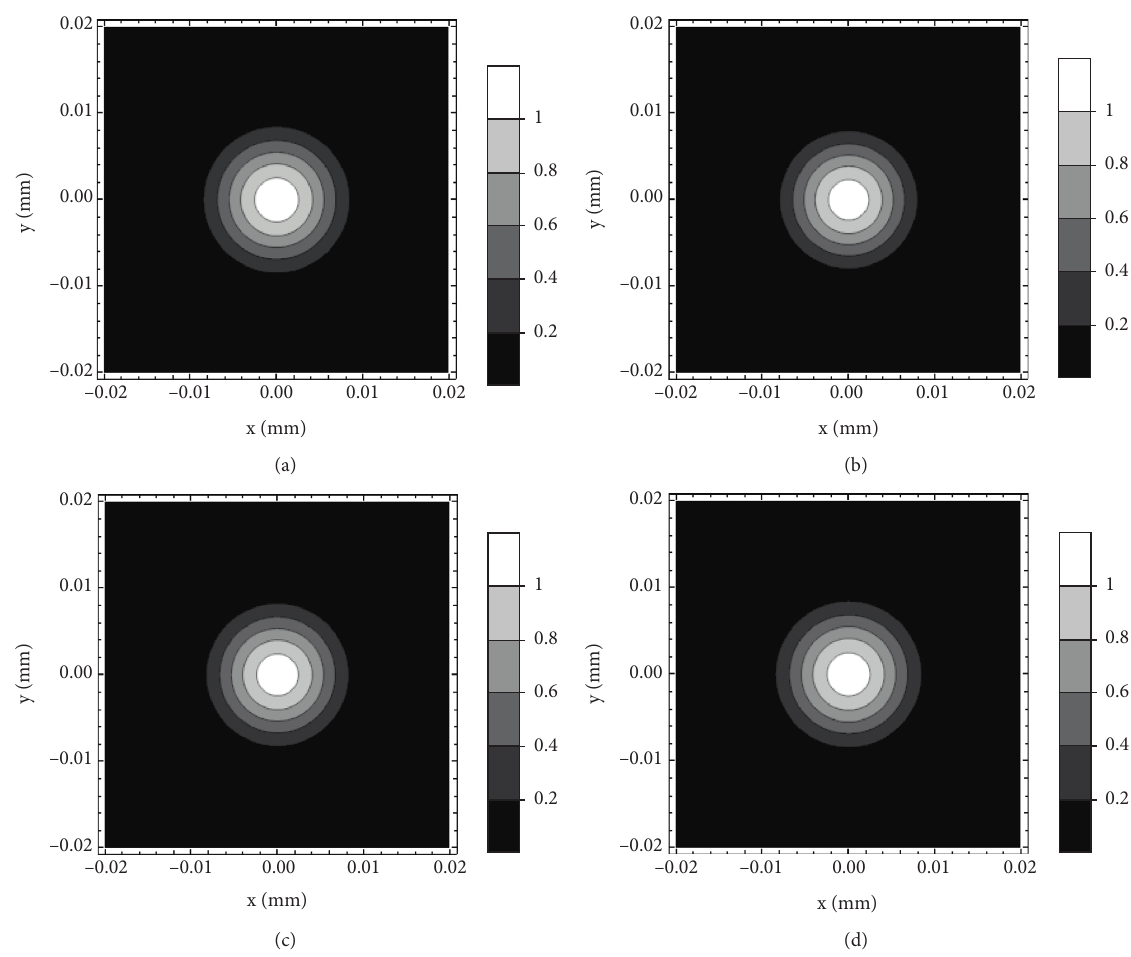
� 5mm, w � 2 mm, w � 7mm, 0 x 0 y 0